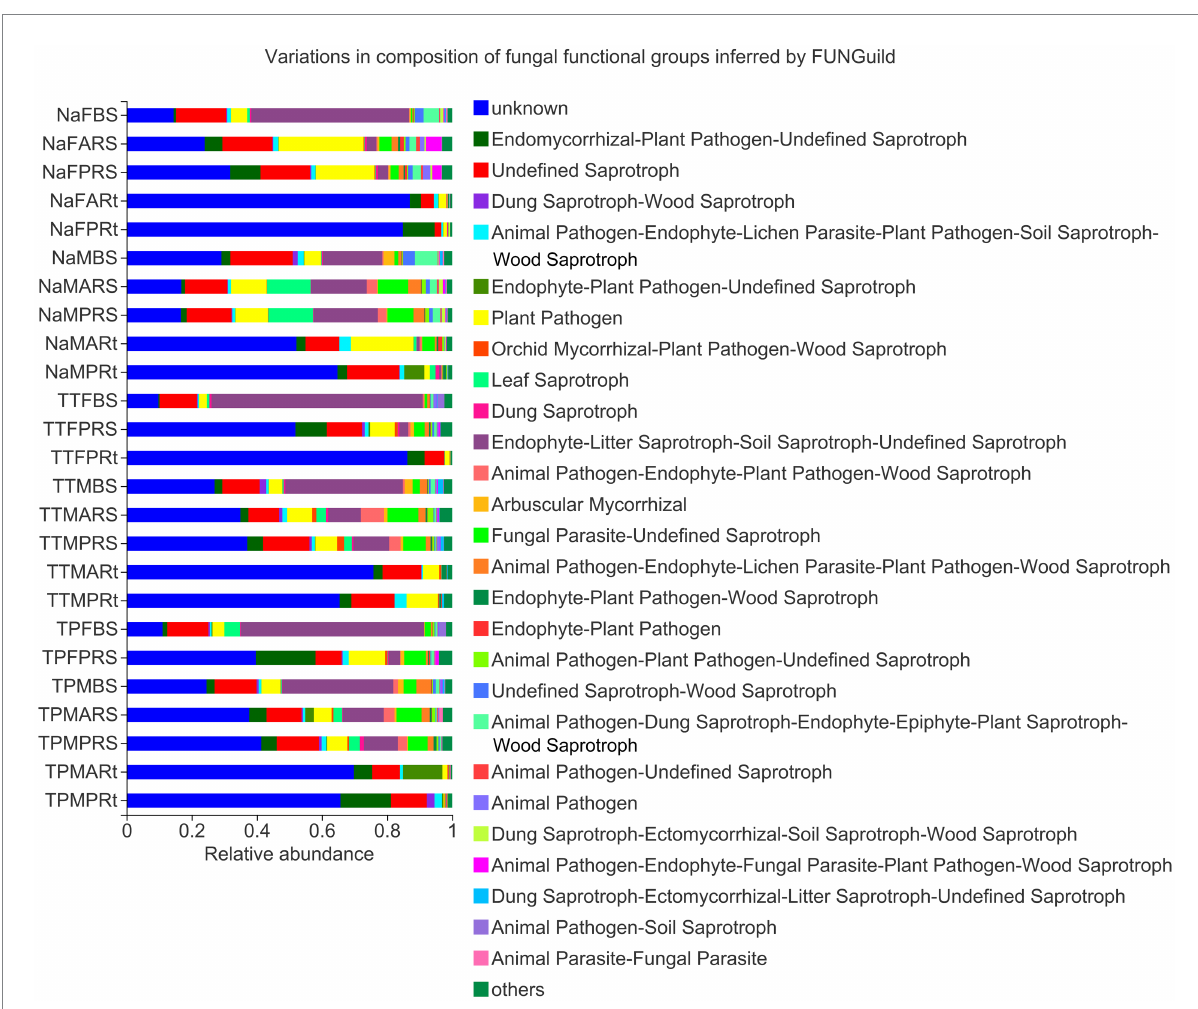
FIGURE 8 Composition of fungal functional groups inferred by FUNGuild. The treatment details are shown in Figure